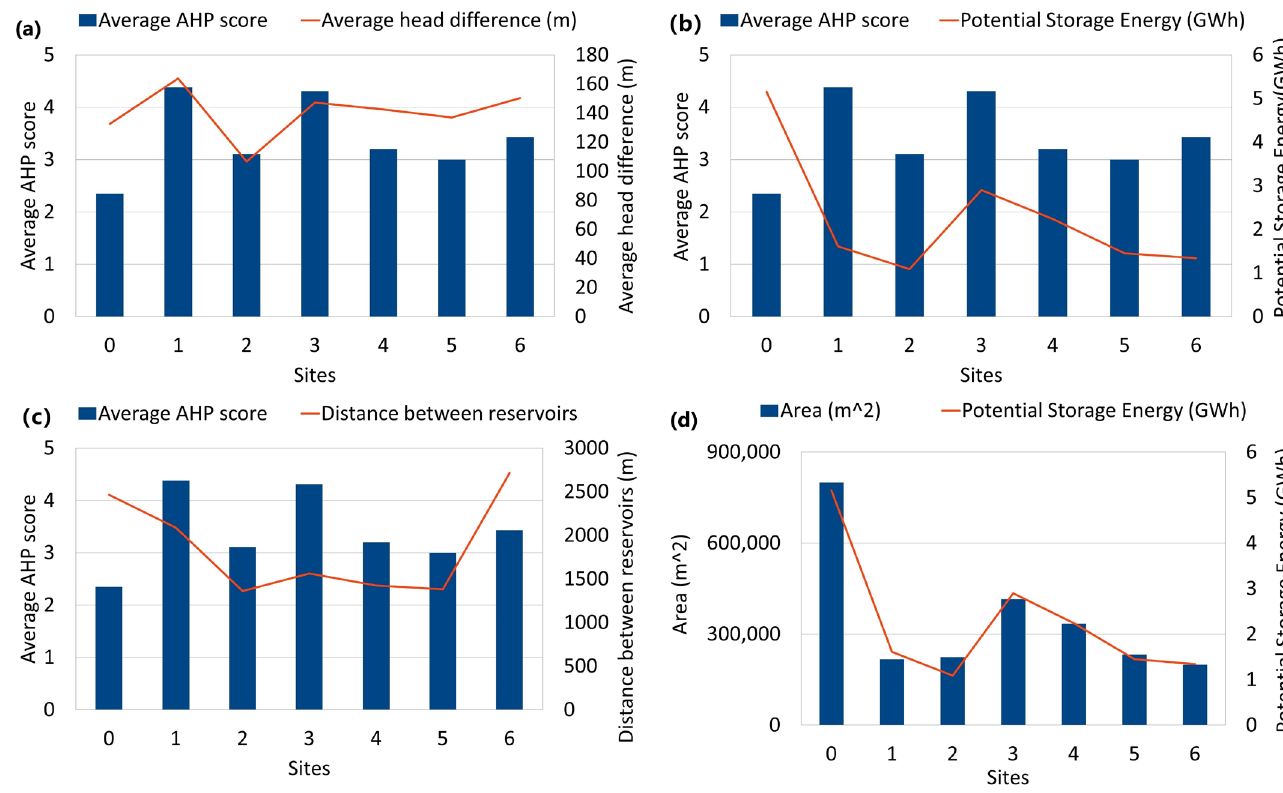
Figure 12. Correlation diagrams between ( a ) the average AHP score versus average head difference (m), ( b ) average AHP score versus potential storage energy (GWh), ( c ) average AHP score in comparison with distance between the two reservoirs, ( d ) potential storage energy (GWh) versus areal coverage.